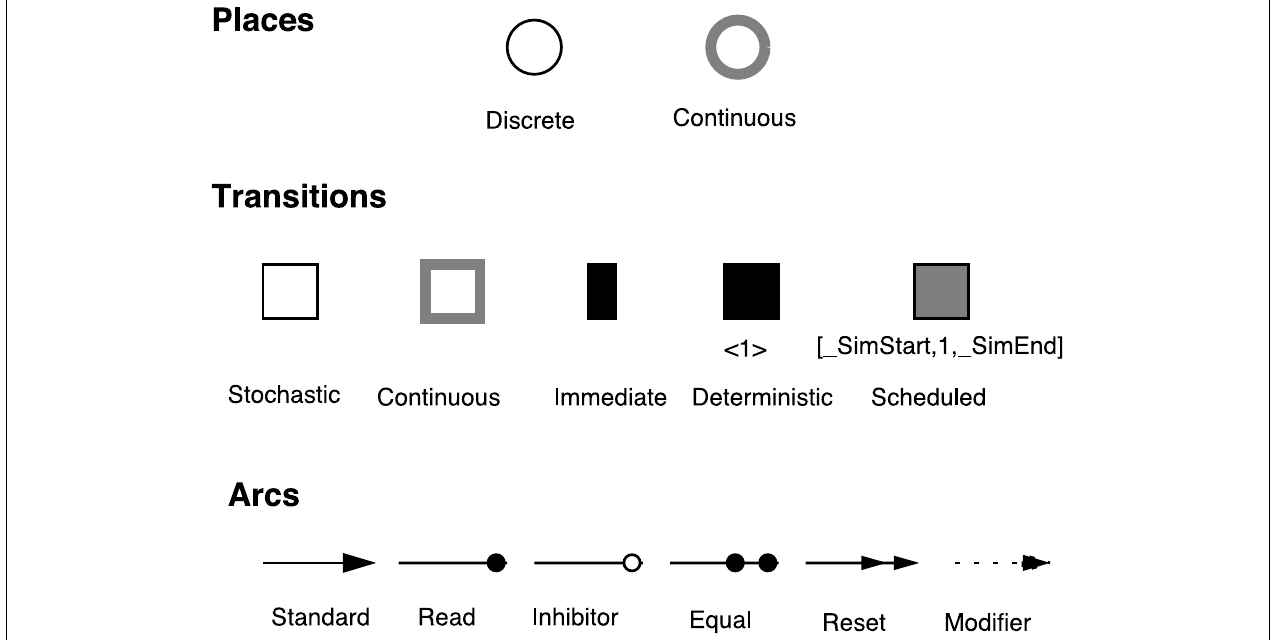
FIGURE 1 | Graphical representation of the GHPN elements (Herajy and Heiner, 2012). Places are classified as discrete and continuous; transitions as continuous, stochastic, immediate, deterministically delayed and scheduled; and arcs as standard, inhibitor, read, equal, reset, and modifier.